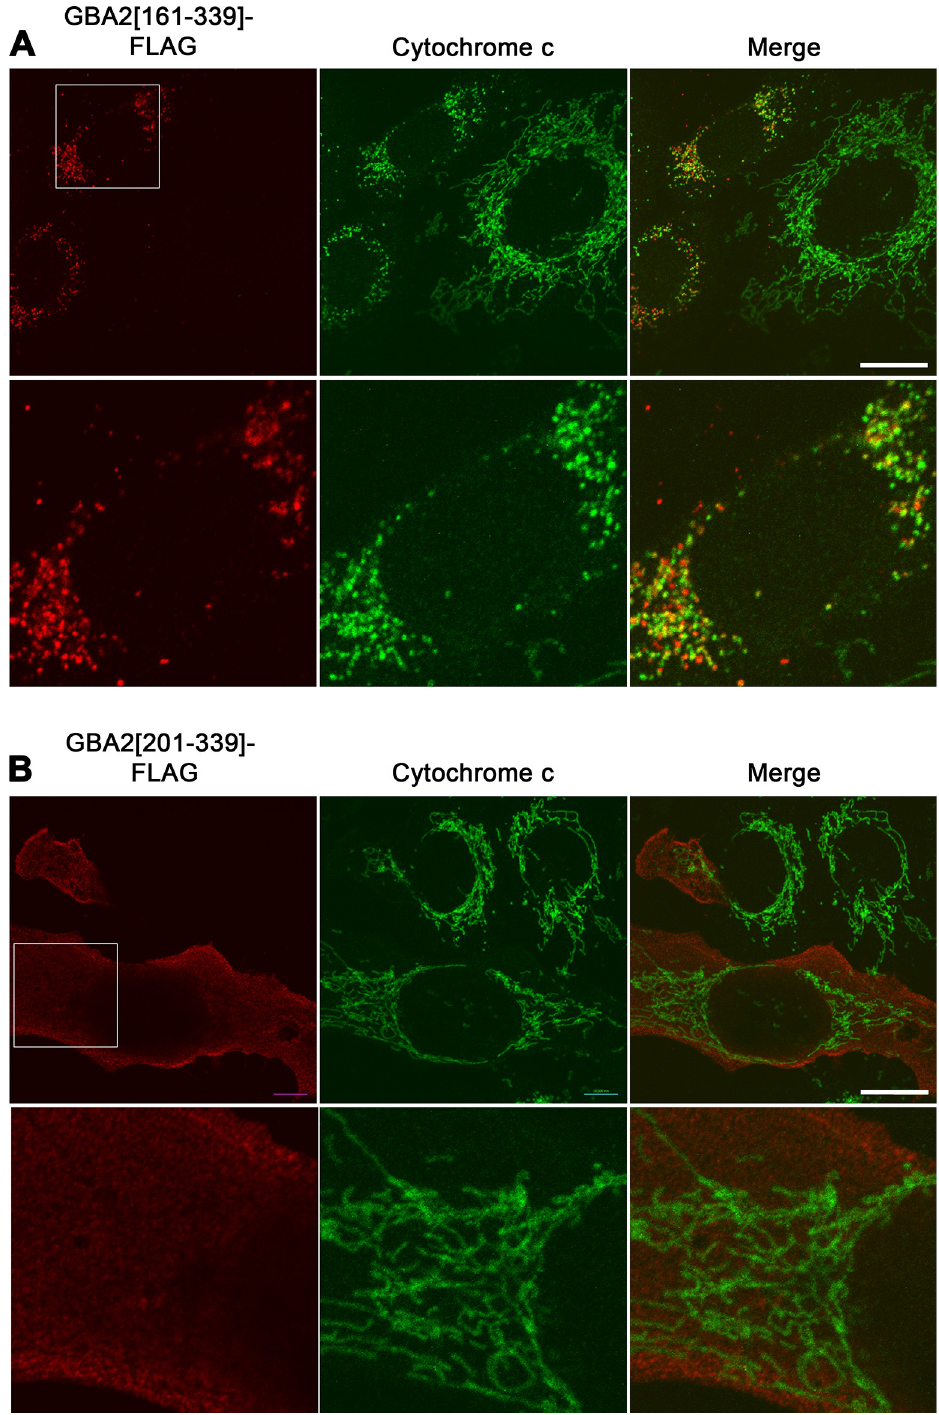
Fig 8. Removal of amino acids 160–200 prevents mitochondrial localization of GBA2-339. U2OS cells transfected with cDNAs coding for (A) GBA2[161–339]-FLAG or (B) GBA2[201–339]-FLAG were immunostained with anti- FLAG (red) and anti-cytochrome c antibodies (green). A section of the images in the upper panels is enlarged in the lower panels, indicated by a white square. Scale bar, 20 μ m.